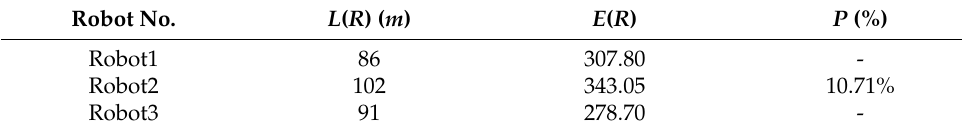
Table 7. Path planning operation parameters of A* algorithm from Experiment 5. Robot No.